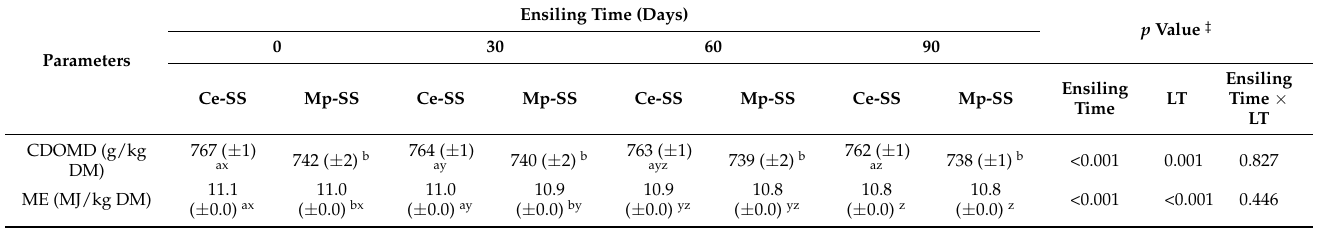
Table 4. Mean ( ± standard deviation) of in vitro cellulase organic matter (CDOMD) digestibility and metabolizable energy (ME) of mixed C. ensiformis (Ce) or M. pruriens (Mp) bean meals with sugarcane stalks (SS) fresh or ensiled for 30, 60 or 90 days ( n =